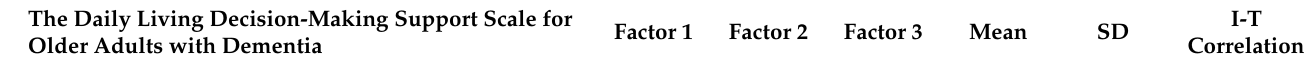
Table 3. Factor analysis of the Daily Living Decision-Making Support Scale for Older Adults with